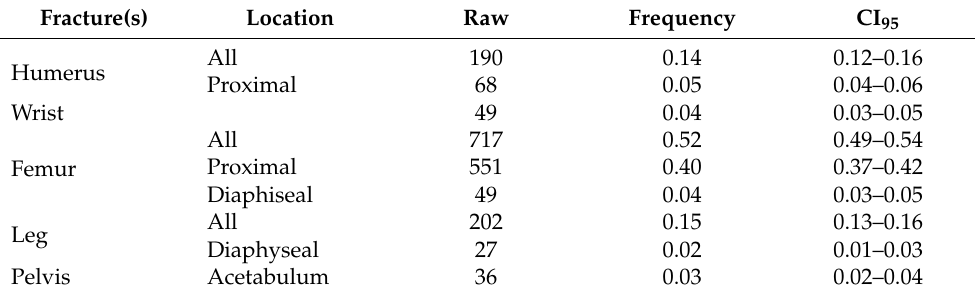
Table 3. Frequency of fractures by